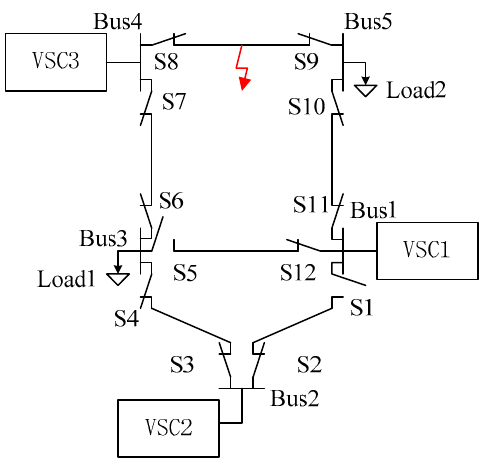
Figure 8. The structure of a multi-terminal loop-type DC distribution network.